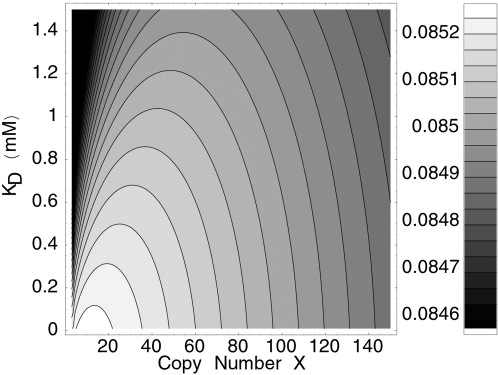
The Optimal Design of the lac Regulatory Network Is Determined by the lac Repressor Copy Number and the Repressor–Lactose Binding Constant.Contour plot of the growth rate as a function of the repressor copy number X and repressor-lactose binding constant K
D. The weighting of the lactose levels is nonuniform. Lower binding constants allow for higher optimal growth rates at lower optimal expression levels for the repressor.